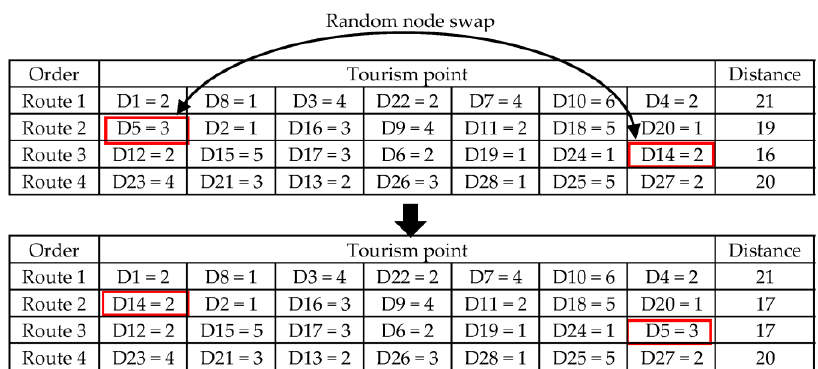
Figure 8. Example of node swap insertion.